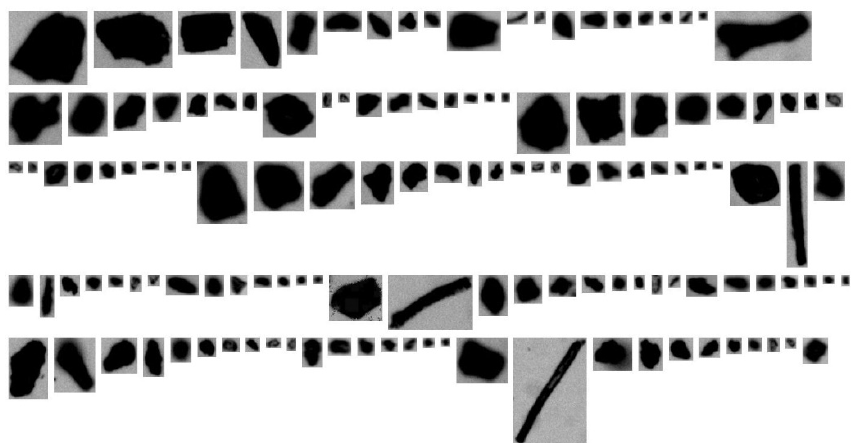
Figure 2. Microscopic images of some road-deposited sediment (RDS) particles of the sample ECL, captured using dynamic image analysis. The particle shape of the other samples was comparable. The images are not scaled.